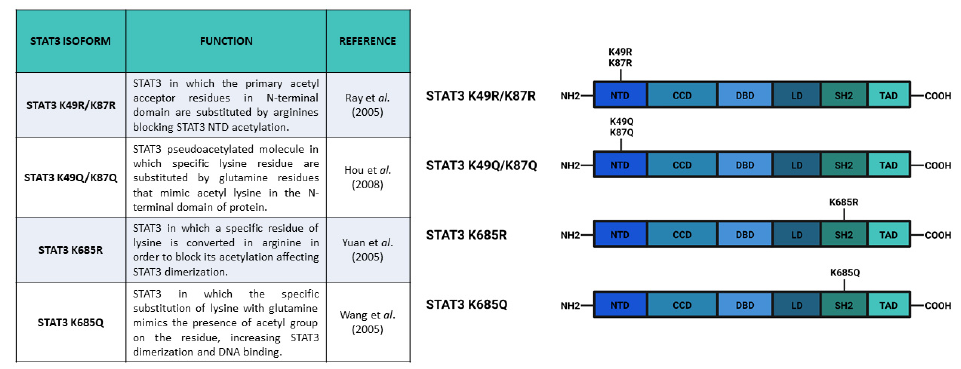
Figure 4. Main constructs used to investigate STAT3 acetylation. Created with BioRender.com. The SH2 domain of STAT3 can be acetylated. Ma and collaborators’ [64] spectrometric analysis showed that p300/CBP could acetylate multiple residues in the SH2 domain: K601, K615, K631, K685, and K707. Ma and co-authors identified these residues as